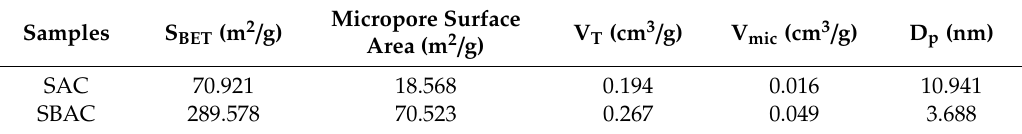
Table 3. Characteristics of porous structure of SAC and SBAC.